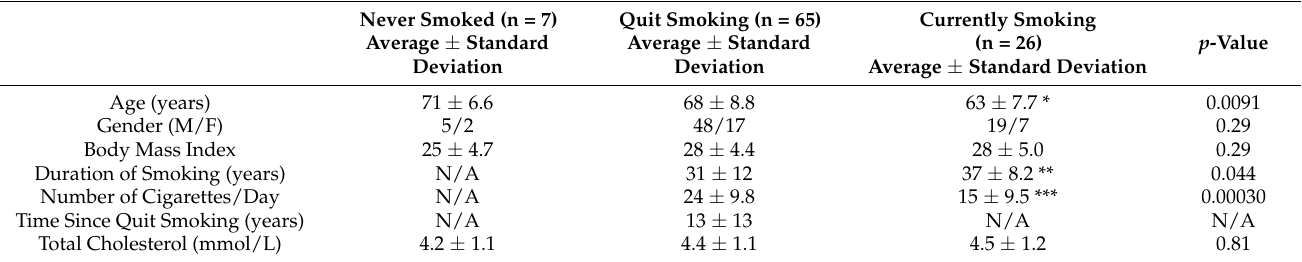
Table 1. Participant Characteristics from the Flax-PAD trial by Smoking